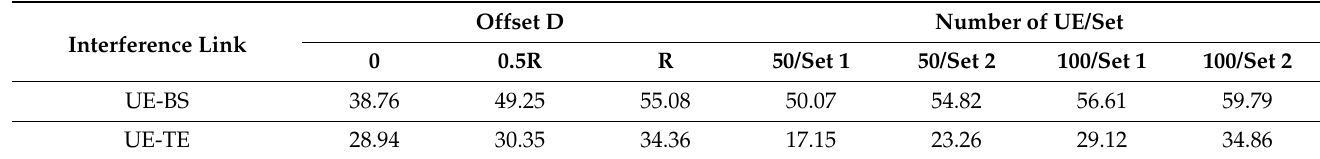
Table 11. The value of ACIR (dB) at 5% throughput